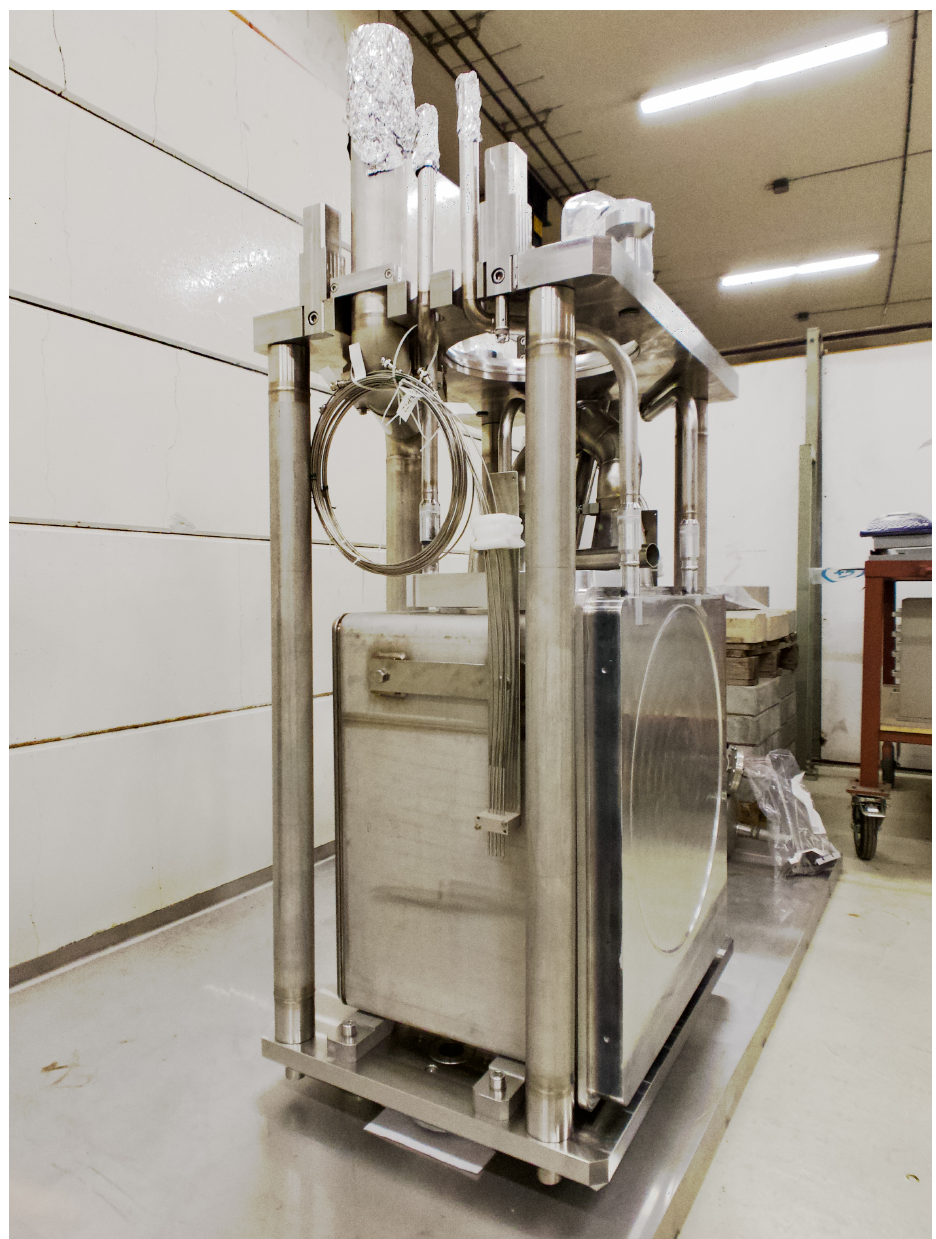
Figure 3. The n_TOF spallation target during the installation phase. The right side station with 5 SPNDs is visible at the centre of the